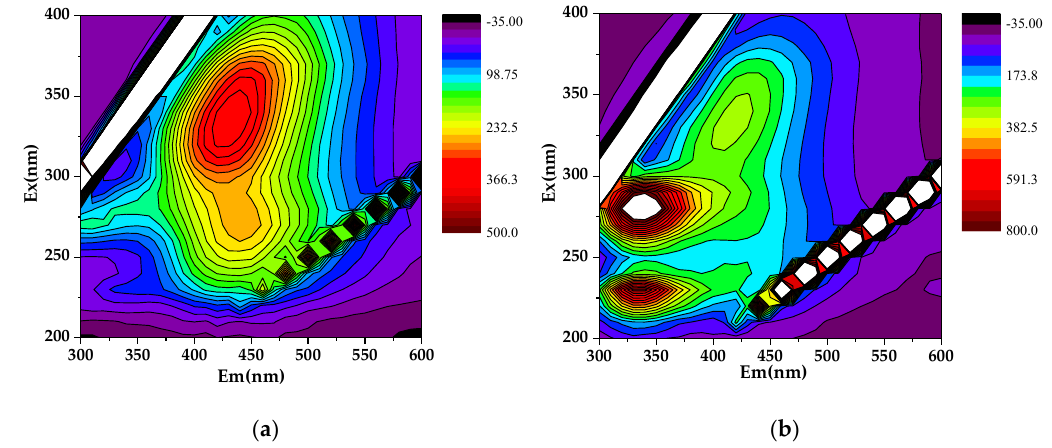
Figure 6. The 3D fluorescence spectra of DOM: ( a ) humus soil; ( b ) sedimentary soil.